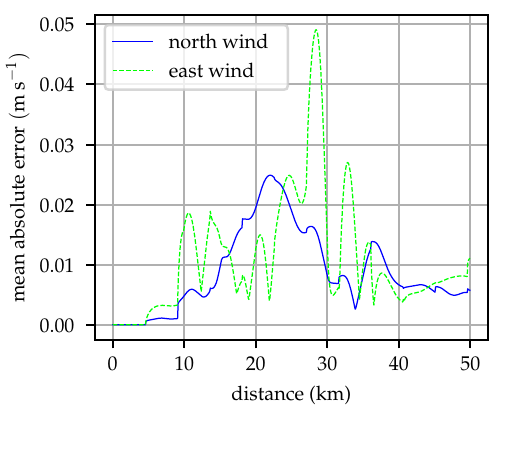
( a ) Mean absolute difference between the wind ( b ) Mean absolute difference between the solar fraction calculated by the two aircraft. components calculated by the two aircraft. Figure 6. Mean absolute difference between the coefficients of the wind and solar models computed by the two aircraft as a function of the travel distance for a simulation beginning at 16:00 UTC on 2018-12-03. During time updates, slight differences in position and inertial velocity introduce small differences between the models maintained by each